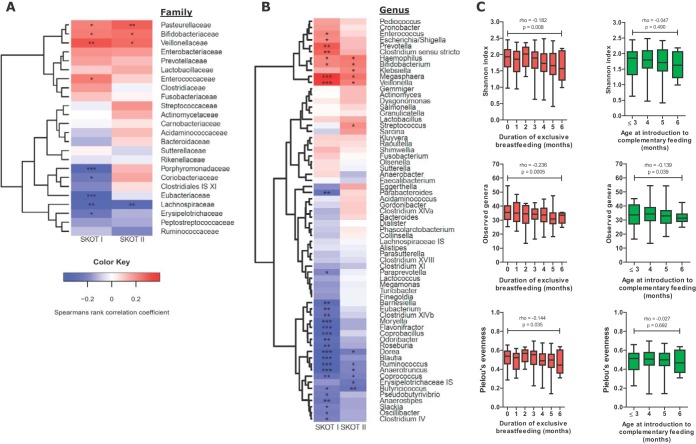
Duration of exclusive breastfeeding is reflected in late-infancy gut microbiota. Hierarchical clustering of Spearman’s rank correlations of duration of exclusive breastfeeding with gut microbial composition at 9 months of age at the family (A) and genus (B) levels in SKOT I and II. *, P < 0.05; **, P < 0.01; ***, P < 0.001. (C) Spearman’s rank correlations of alpha diversity measures (Shannon index, observed genera, and Pielou’s evenness index) to duration of exclusive breastfeeding (0 to 6 months) and age at introduction of complementary feeding (3 to 6 months) for compiled data from SKOT I and II. Boxes indicate 25th to 75th percentiles, with mean values marked as a line and whiskers indicating minimum and maximum values.